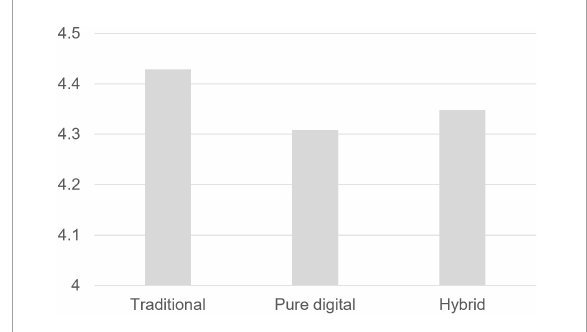
FIGURE4 Training effectiveness: traditional, pure digital, and hybrid.